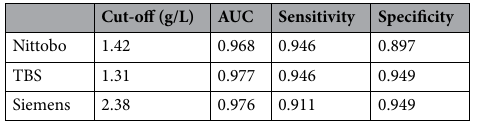
Table 3. Cut-off value and AUC for each reagent. AUC area under ROC